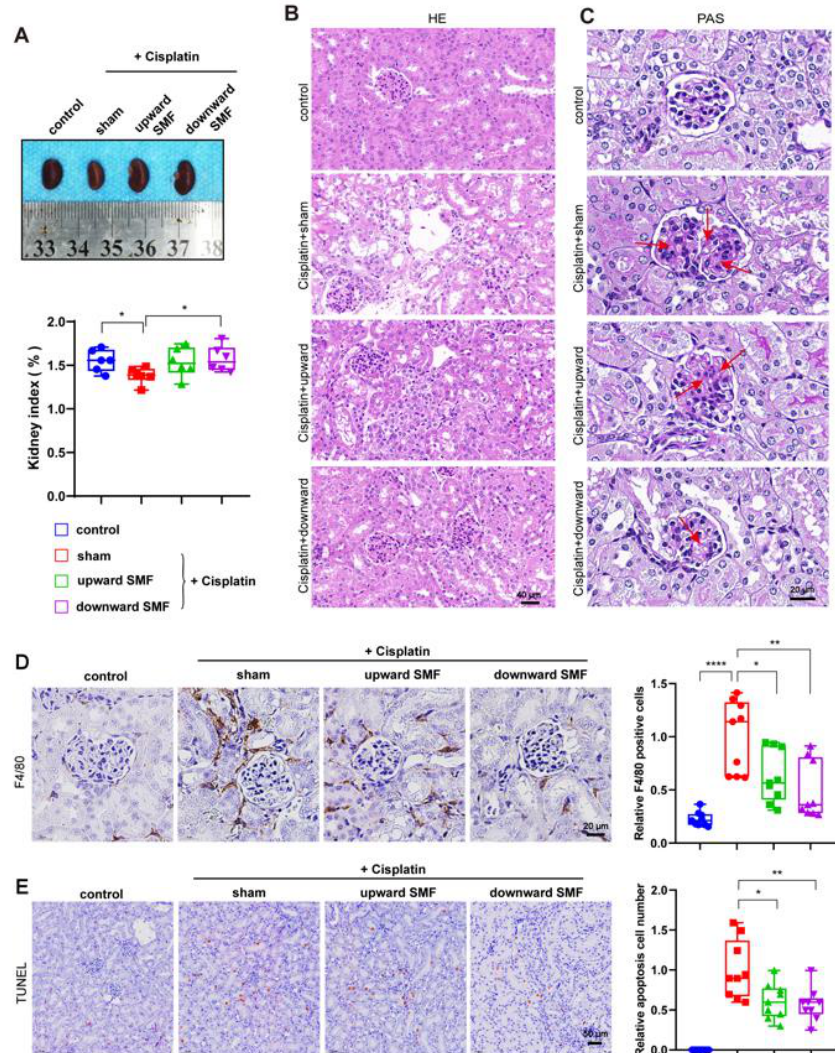
Figure 4. SMFs protect against cisplatin-induced kidney injury. ( A ) Representative images of kidneys and quantification of the kidney index, which is the percentage of kidney weight in the whole-body weight of the mice. ( B , C ) Representative HE ( B ) and PAS ( C ) staining of kidney sections. The arrows represent glomerular thylakoid hyperplasia. ( D ) Representative images of F4/80 staining in the mice’s kidneys and quantification of relative F4/80 positive cells. ( E ) Representative images of TUNEL staining in the mice’s kidneys and quantification of relative apoptotic cells. Values show means ± SD. * p < 0.05, ** p < 0.01, **** p <